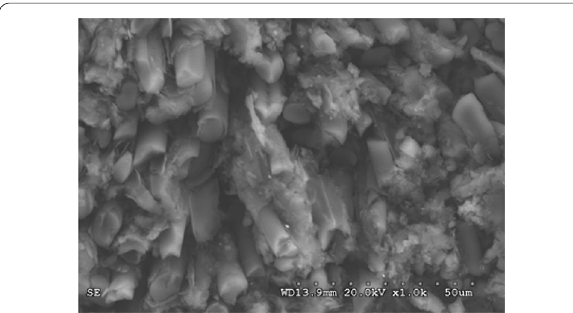
Figure 1 Cross-section of unidirectional CFRP composites